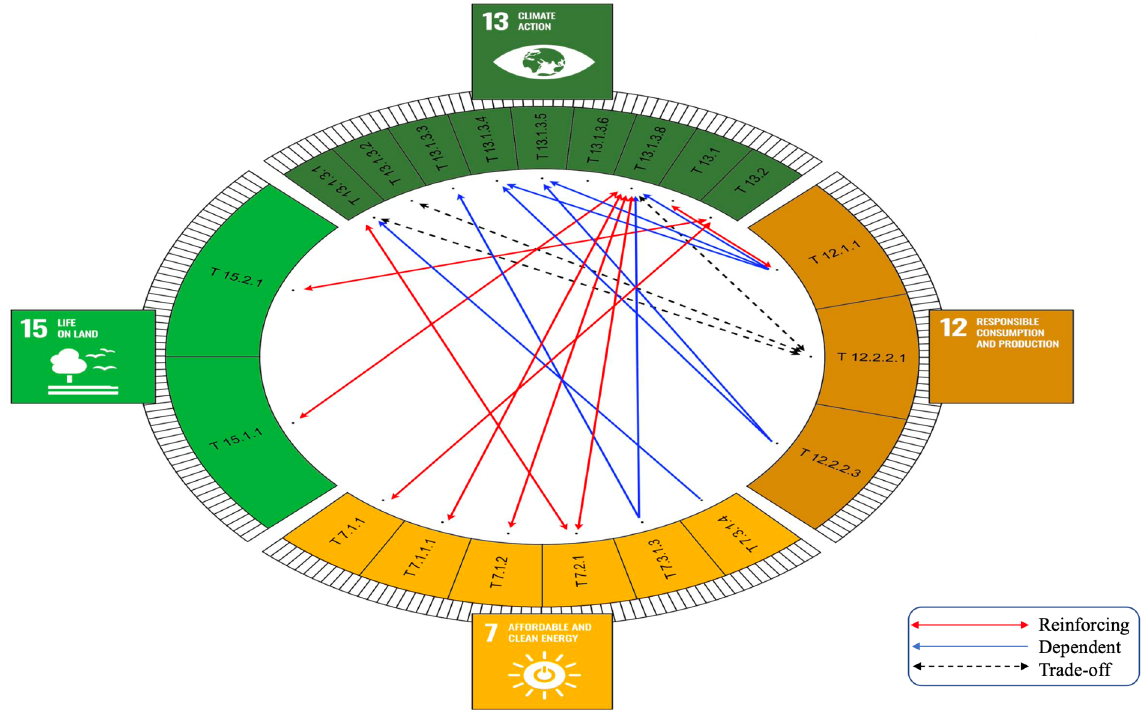
Figure 8. Linkages Among the Targets Associated with SDG 7, 12, 13 &15.